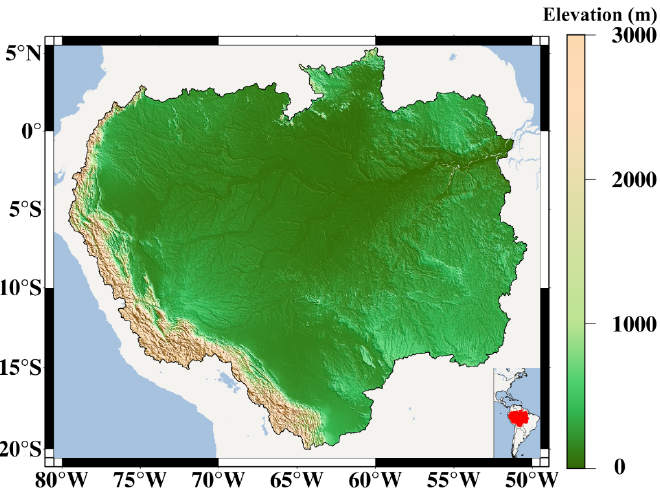
Figure 1. The digital elevation models of the